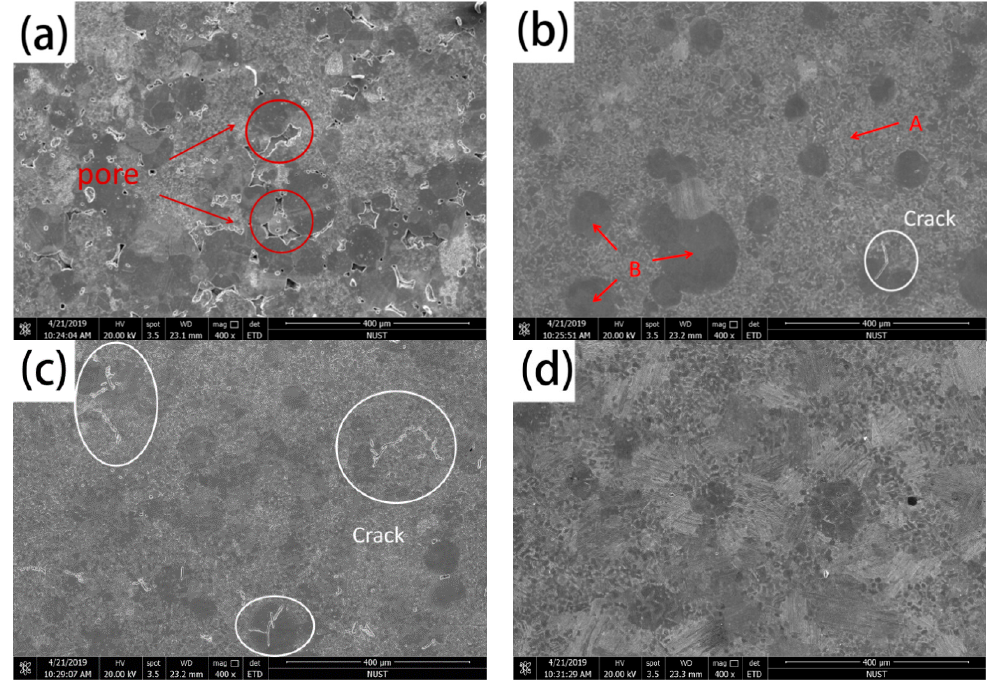
Figure 9. Microstructure of Ti-48Al-2Cr-8Nb alloy prepared by the SP powder with different sintering temperatures: ( a ) 1200 ◦ C, ( b ) 1250 ◦ C, ( c ) 1300 ◦ C, and ( d ) 1350 ◦